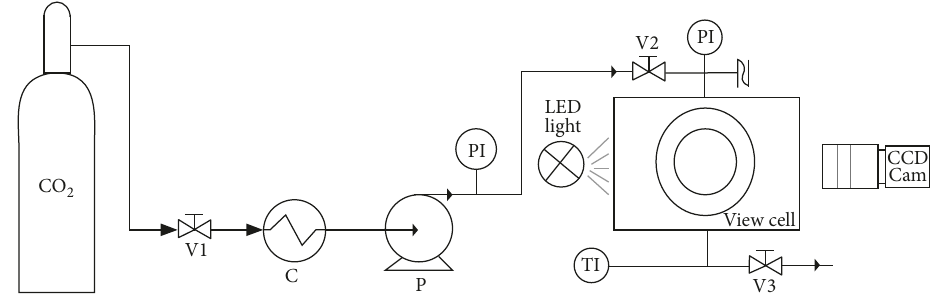
Figure 1: Schematic presentation of the view cell.